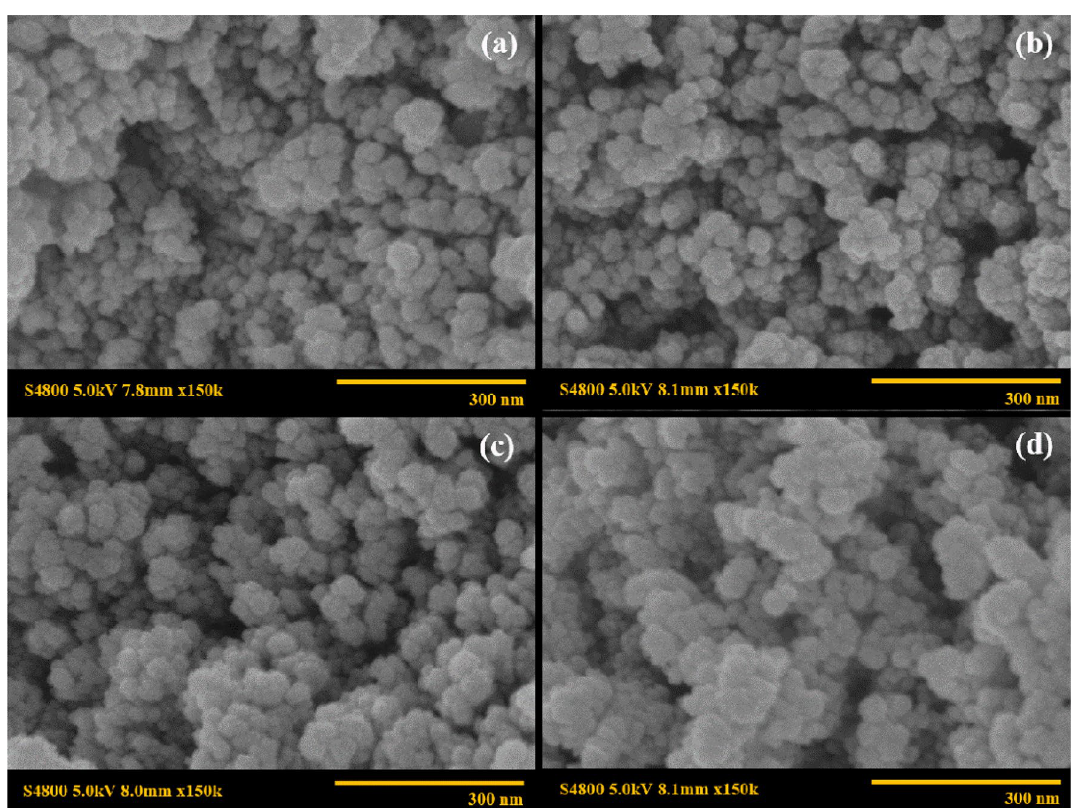
Figure 7. SEM images of Co x Fe 1−x Fe 2 O 4 : ( a ) CoFe 2 O 4 _SDS_1.2CMC; ( b ) Co 0.6 Fe 0.4 Fe 2 O 4 _SDS_1.2CMC; ( c ) Co